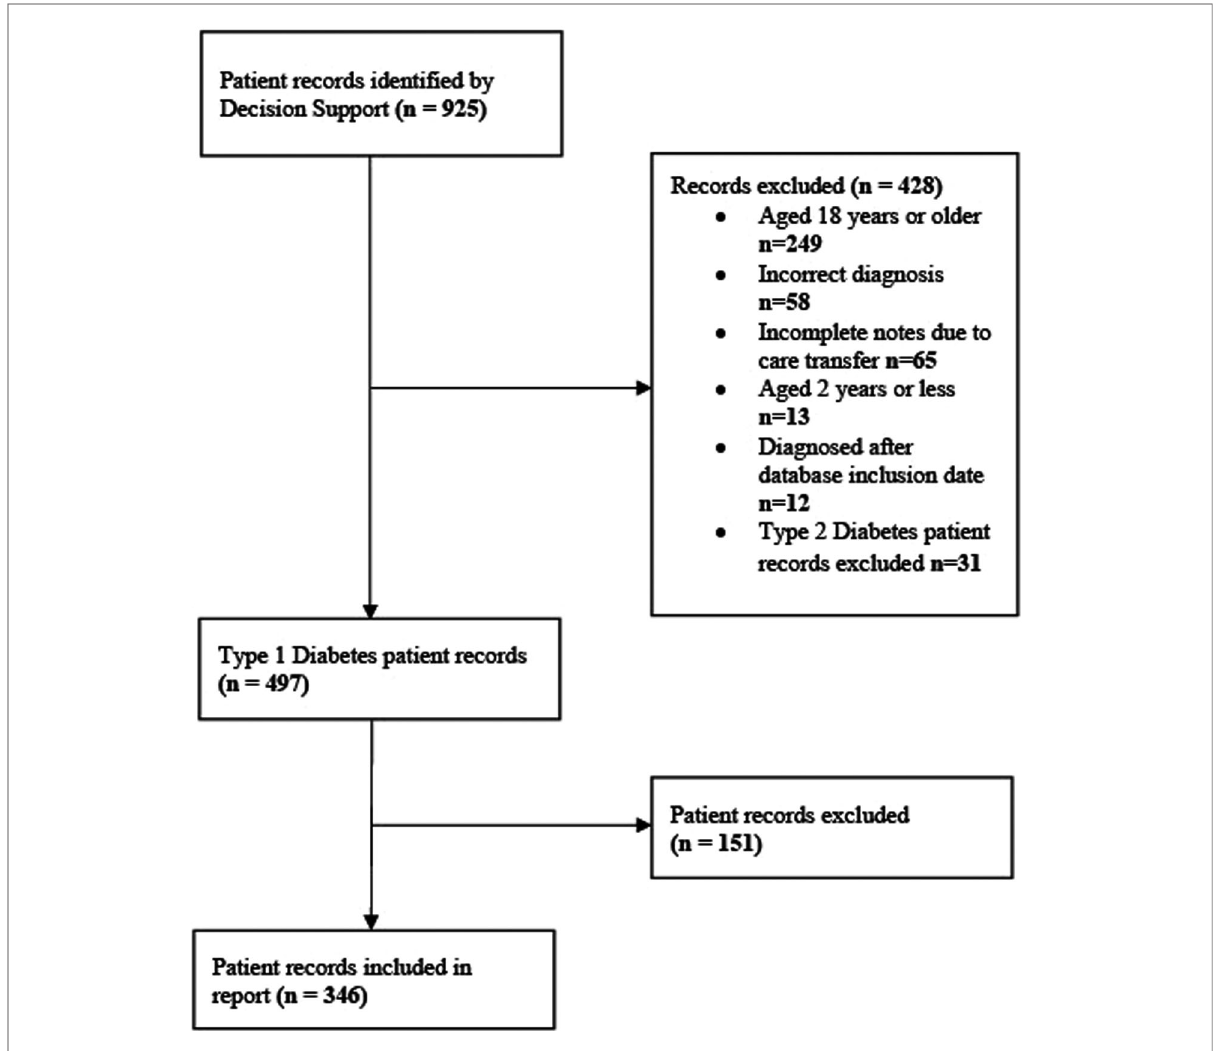
FIGURE 1 Selection process for included